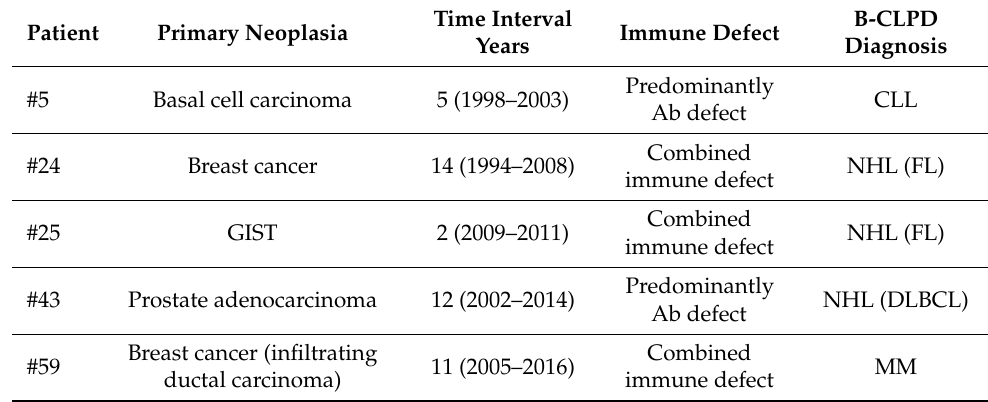
Table 4. Time interval between a primary neoplasia diagnosis and B-CLPD